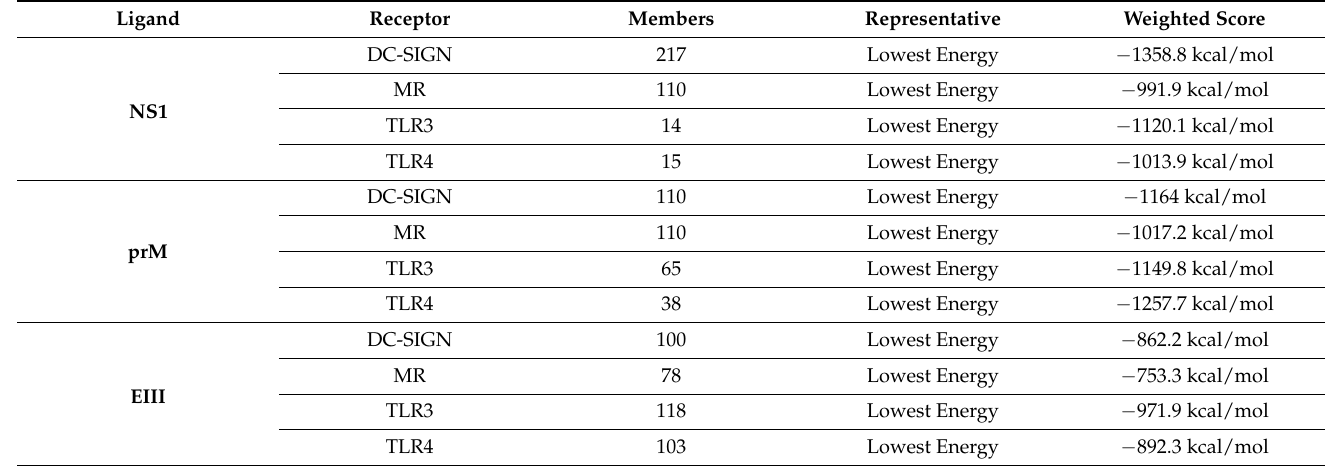
Table 7. Docking between immune receptors associated with dengue virus, i.e., DC-SIGN, mannose- binding receptor (MR), TLR3, and TLR4, and candidate vaccine